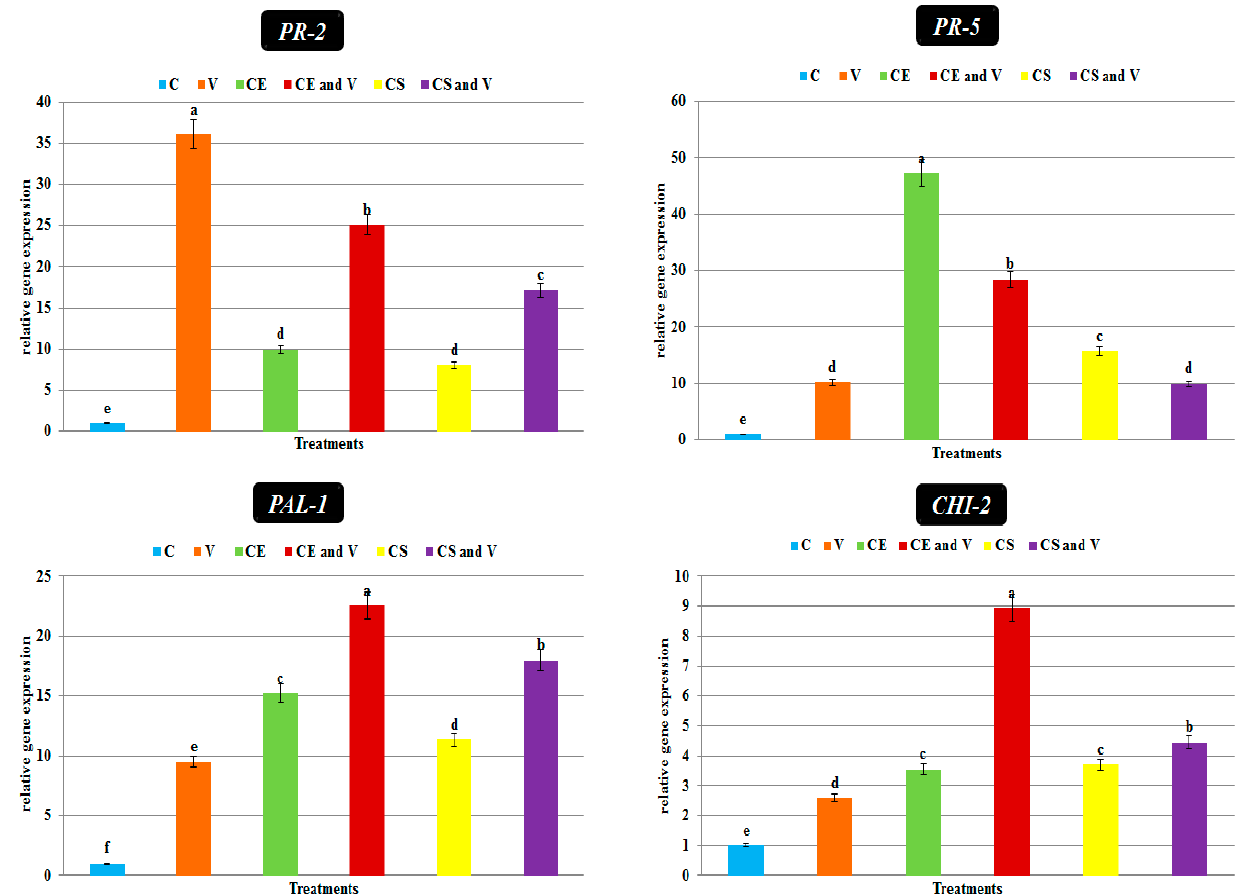
Figure 9. The quantitative gene expression levels of two pathogenesis-related protein genes ( PR-2 and PR-5 ), one polyphenolic gene ( PAL-1 ), and one flavonoid gene ( CHI-2 ) at 28 dpi. C: control potato plants; V: potato plants inoculated with PVY; CE: potato plants treated with Egyptian nanoclay; CE and V: potato plants inoculated with Egyptian nanoclay 48 h before PVY inoculation; CS: potato plants treated with standard nanoclay; CS and V: potato plants inoculated with standard nanoclay 48 h before PVY inoculation. The columns reflect the average value of five biological replicates, while the bars represent the standard deviation (SD). According to Tukey’s HSD test ( p ≤ 0.05), the values of each column following the same letter (a/b/c/d/e/f) do not significantly differ.